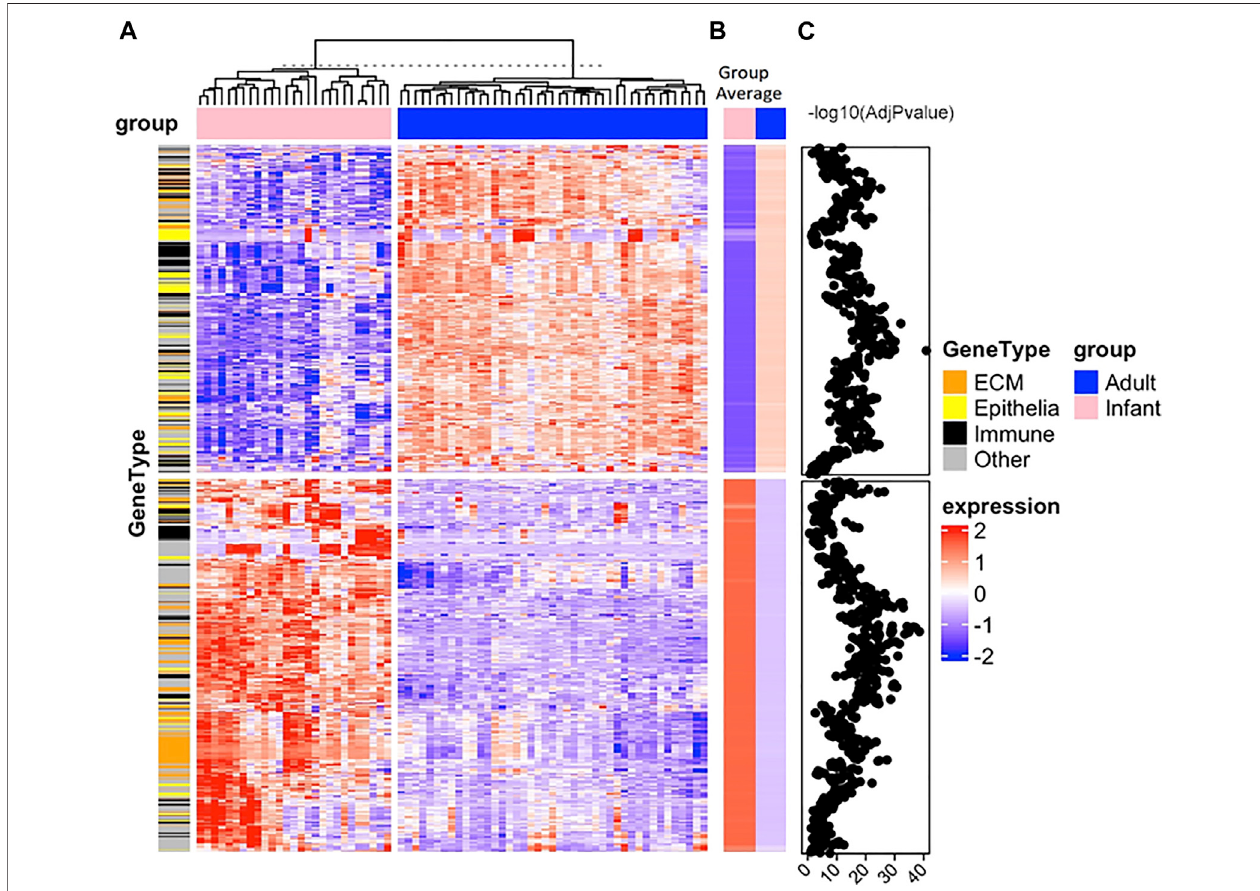
FIGURE 7 | Hierarchical clustering analysis of differentially expressed genes in newborn infant and adult skin samples. Full-thickness tissue samples (body site, non-foreskin) from 27 infants were collected at non-elective surgery and buttockstissue(protected from ultravioletradiation exposure) from 43adults wasprocessed to collecttotalRNA(Visscheretal.,2021).GeneexpressionwasdeterminedfrommRNAusingAffymetrixGeneTitanU219arrayplates.Thelowest30%ofthe49,386gene transcripts were removed, assayed for quality, data was normalized and Log2 transformed, analyzed using linear models and differential expression analyses and analyzed and analysis of variance with a term for the combination was conducted, as previously described (Merico et al., 2010; Supek et al., 2011; Yu et al., 2012; Gu et al., 2016;Szklarczyket al.,2019; Visscher et al., 2021).Rigorous quality controlwasapplied and alldatawereMIAME compliant. TheEmpirical Bayesmethod (limma R-package) was used to test comparisons. Test statistics were moderated with the Empirical Bayes method (limma R-package). The Benjamini – Hochberg correction was used to control for false discovery rates. The complete linkage method using the R hclust function was used to perform hierarchical clustering. Genes that were signi fi cantly expressed were analyzed for enrichment of biologic themes (Gene Ontology) using the clusterPro fi ler package (Yu et al., 2012), EnrichmentMap (Merico et al., 2010), g:pro fi ler (Raudvere et al., 2019), Revigo (Supek et al., 2011) and String database (Szklarczyk et al., 2019). The transcriptomics is in the NCBI Gene ExpressionOmnibus(GEO)repositorywiththedatasetaccessionnumberGSE181022.Panel (A) isaheatmapofthenormalizedexpressionvalues(basedonz-score)of the1,086differentiallyregulatedgeneswithadjusted p value < 0.05andabsolutefoldchange ≥ 1.5forthetwogroups,infants(pink)andadults(blue).Euclideandistances between each sample were determined and cluster analysis was performed with an unsupervised hclust algorithm. Samples formed two clusters. From a hierarchical cluster,analysisgenesweregroupedforsimilaritywhereeachcolumnisanindividualsampleandeachrowisasinglegene.Extracellularmatrix(ECM,orange),immune- related(black),andepithelial(yellow)genesareindicatedontheannotationbarunderthegenetype.Panel (B) isaheatmapofgroupaveragevaluesforinfants(pink)and adults(blue).Panel (C) arethevaluesofthenegativelog 10 oftheadjusted p valuesfromtheLimmatestingforadultsversusinfantsforeachgene.Thez-scoresareshown in the blue-white-red gradient where 2 is the darkest red color, 0 is white and -2 is the darkest blue color shown on the right and labeled as “ expression ” . Many negative log 10 adjusted p values were greater than 10, indicating large